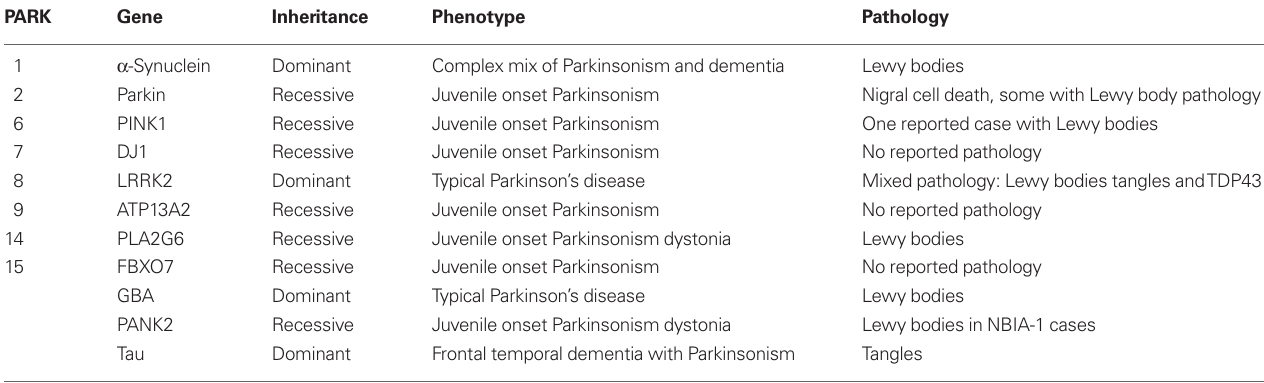
Table 1 | Genes linked to autosomal forms of Parkinsonism.